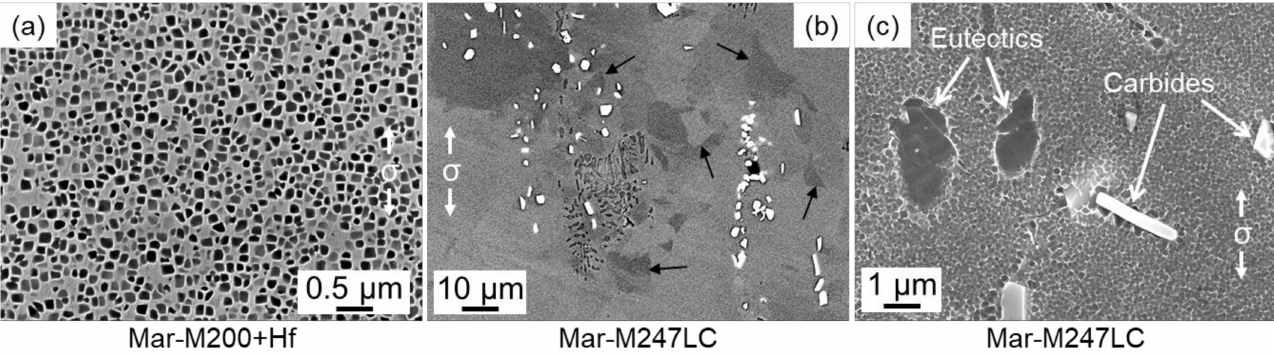
Figure 7. Microstructures after creep rupture tests at 1250 ◦ C/60 MPa. ( a ) Mar-M200+Hf, 5 mm from the fracture surface. ( b , c ) Mar-M247LC, middle of the gauge section. ( b ) was obtained using BSE imaging mode. Black arrows are pointing at grain